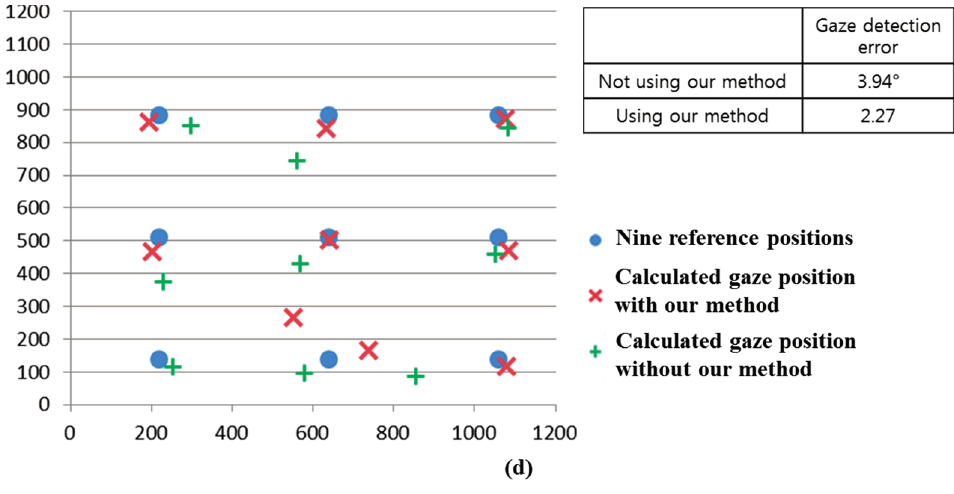
Figure 29. Comparisons of gaze detection errors with five people wearing glasses without and with our method of Section 2.5 in the presence of the halogen lamp at various positions (like Figure 25) ( a ) above monitor display; ( b ) right of monitor display; ( c ) below monitor display; ( d ) left of monitor